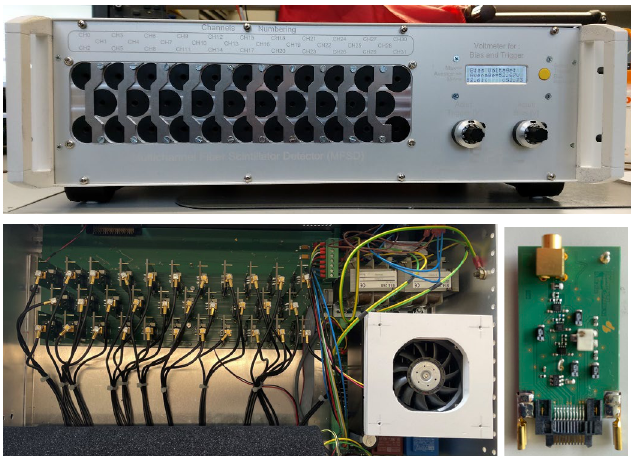
Fig. 9. Front-end (a) and internal (a) of a 32-channel module developed at LRS. One of the 32 fast-preamplifier board installed in the module